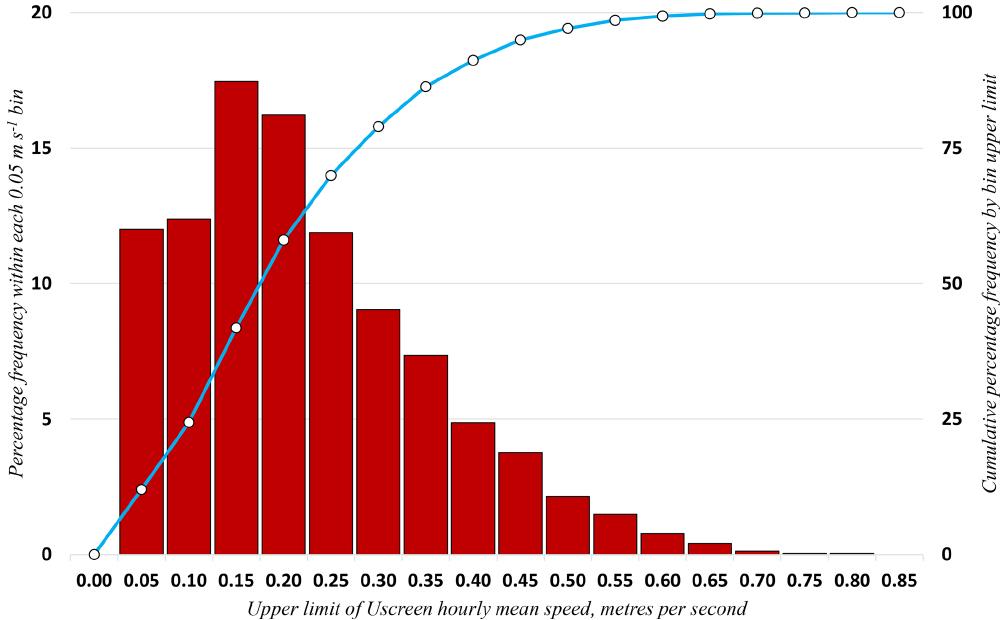
Figure 8. Percentage frequency distribution of hourly mean screen ventilation U screen within 0.05ms − 1 bins. The red columns show per-bin frequency (left vertical axis), and the blue line and markers show the cumulative percentage frequency below upper bin limit (right vertical axis). There is a total of 2423 observations, with an hourly mean speed of 0.20ms − 1 , a median of 0.18ms − 1 , a minimum of 0.01ms − 1 , and a maximum of 0.78ms − 1